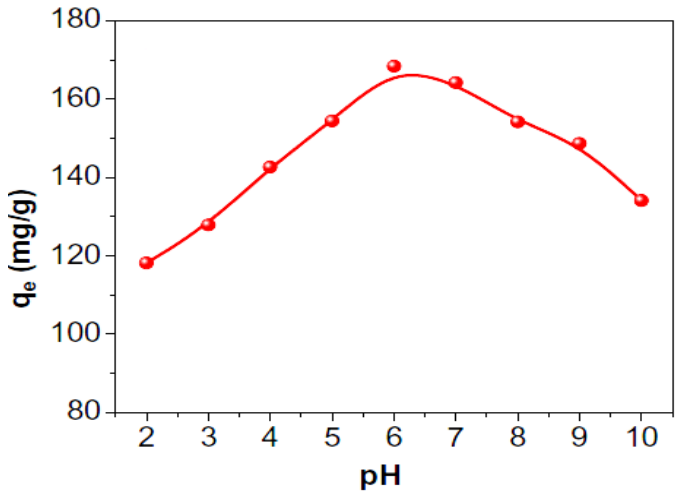
Figure 7. pH effect for the removal of TC from aqueous solution by using CDF@MF composite adsorbent [19].